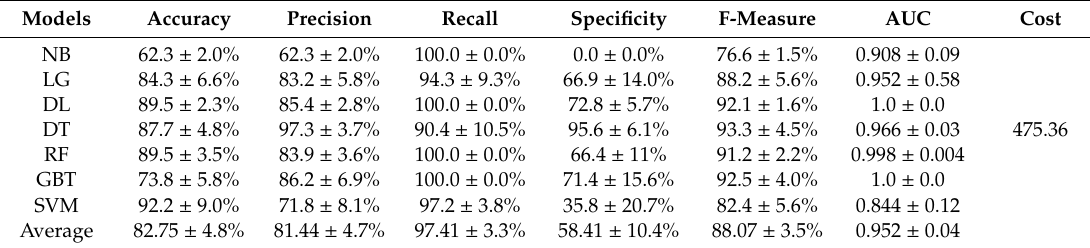
Table 6. Evaluation results for baseline models.